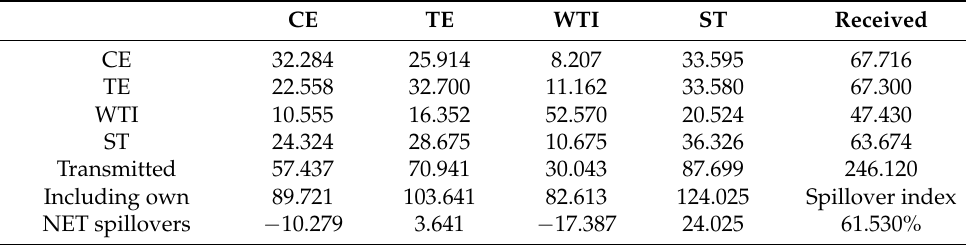
Table 2. Static connectedness spillover estimates among four